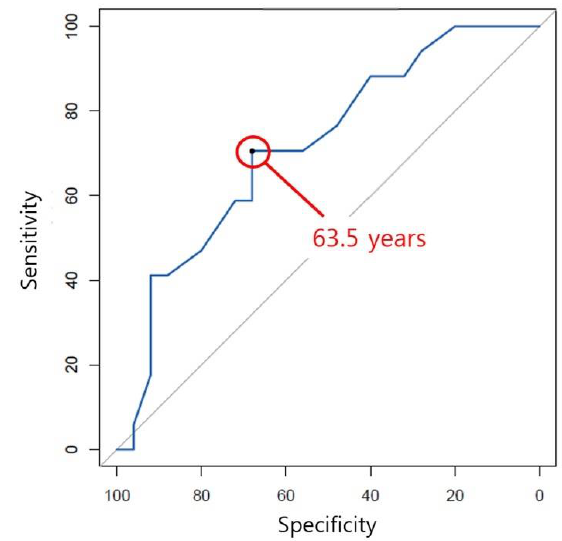
Figure 2. The receiver operating characteristic curve for osteoarthritis progression showed that the cutoff age was 63.5 years with the area under the curve being 0.72 (sensitivity, 68.0%; specificity, 70.6%).